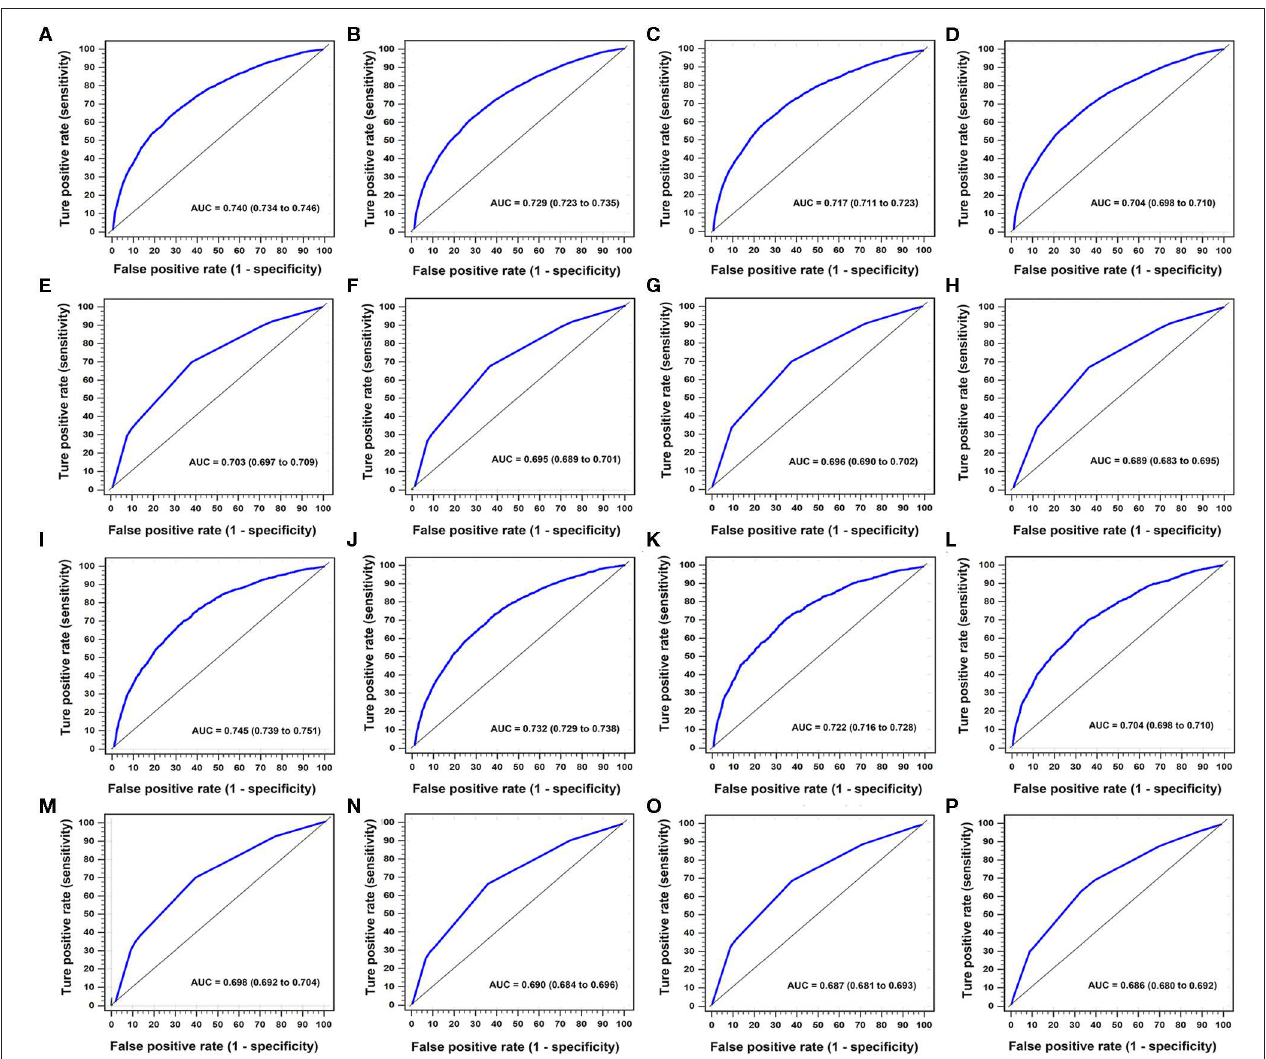
FIGURE 4 | Time-dependent areas under receiver-operating characteristic (ROC) curves (AUCs) in training and validation cohorts for three- and five-year OS. In training cohort, (A, B) were nomogram 1 for three- and five-year OS, respectively. (C, D) were nomogram 2 for three- and five-year OS, respectively. (E, F) were AJCC 8th TNM classification for three- and five-year OS, respectively. (G, H) were AJCC 6th TNM classification for three- and five-year OS, respectively. In validation cohort, (I, J) were nomogram 1 for three- and five-year OS, respectively. (K, L) were nomogram 2 in three- and five-year OS, respectively. (M, N) were AJCC 8th TNM classification for three- and five-year OS, respectively. (O, P) were AJCC 6th TNM classification for three- and five-year OS,